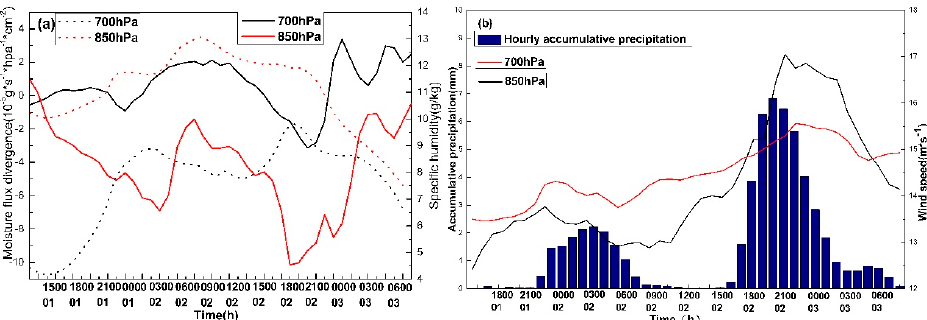
Figure 7. ( a ) Temporal evolution of area-averaged specific humidity (dotted line, g·kg − 1 ) and moisture flux divergence (solid line, 10 − 5 g·s − 1 ·hPa − 1 ·cm − 2 ); ( b ) mean hourly precipitation (mm) and intensity of double LLJs (m·s − 1 ) in the precipitation zone (30.25° N–31.55° N, 106.05° E–108.05° E).